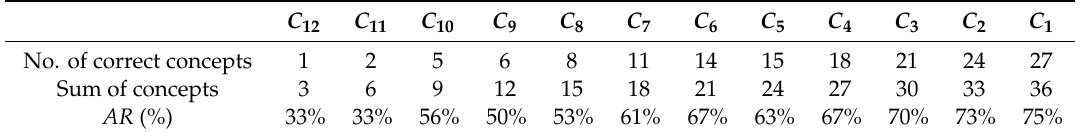
Table 3. Learning achievement results for student 2, who correctly answered Q 1 – Q 12 , Q 15 – Q 23 , Q 26 , Q 28 – Q 30 , Q 32 , and Q 35 .